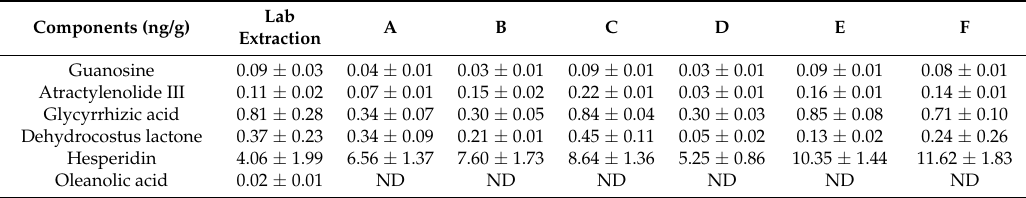
Table 4. The contents of guanosine, atractylenolide III, glycyrrhizic acid, hesperidin, dehydrocostus lactone, and oleanolic acid in a lab-prepared herbal extract, and six brands (A–F), of XSLJZT herbal pharmaceutical